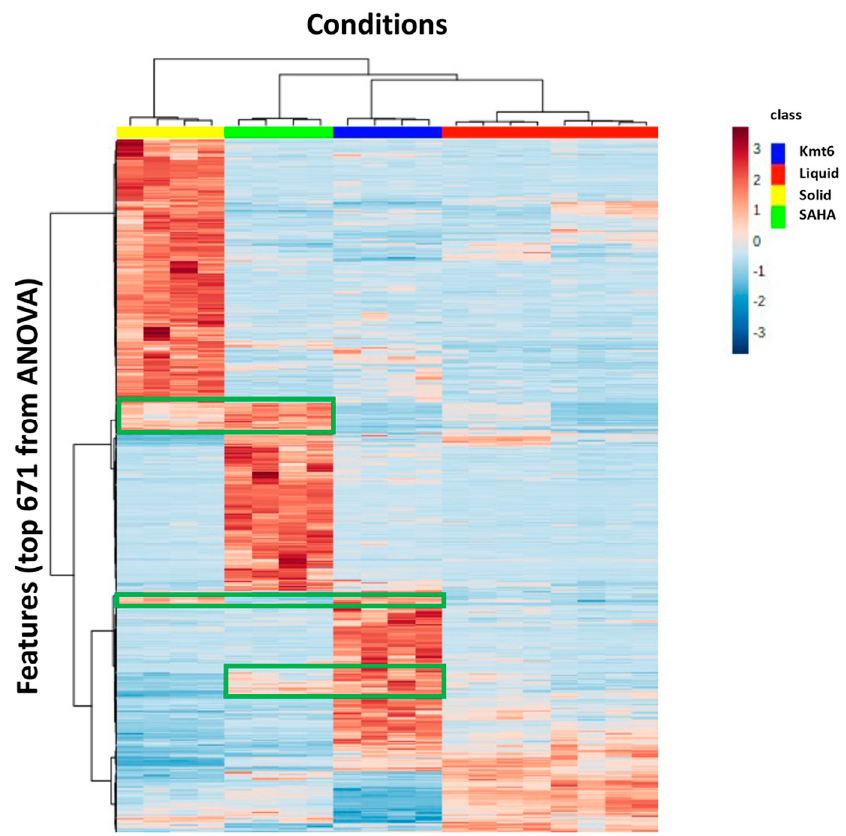
Figure 3. Hierarchical clustering analysis (HCA) of the most significant variable features ( p − value < 0.001): 671 features (determined by their m / z ratio and retention time ( t R )) among the samples corresponding to the four different conditions and represented on a heatmap, ranging from red color for high peak areas to blue. The heatmap was established by using the normalized and scaled peak areas of the 671 features. “Liquid”: M2 liquid medium inoculated with WT; “Solid”: M2 solid medium inoculated with WT; “SAHA”: M2 liquid medium supplemented with 100 µ M SAHA and inoculated with WT; Kmt6: M2 liquid medium inoculated with the Kmt6 mutant strain. All the experiments were performed in quadruplicates, except for the condition “Liquid” for which 8 replicates are presented. The green squares highlight some features that are detected in at least two different conditions.